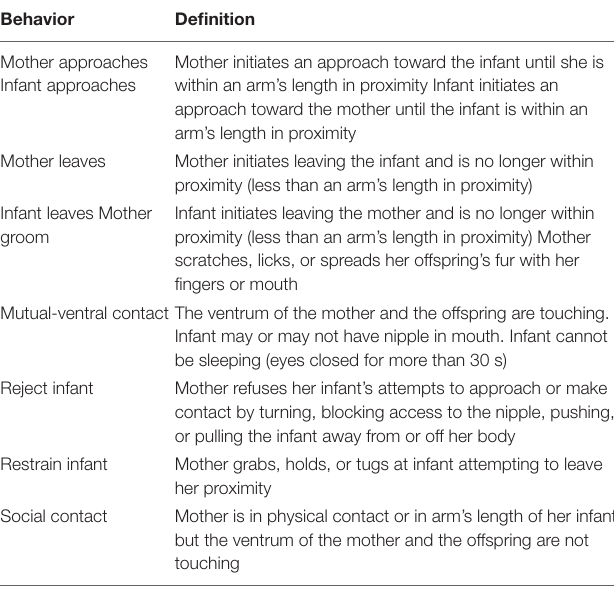
TABLE 2 | Mother-infant ethogram with behavioral